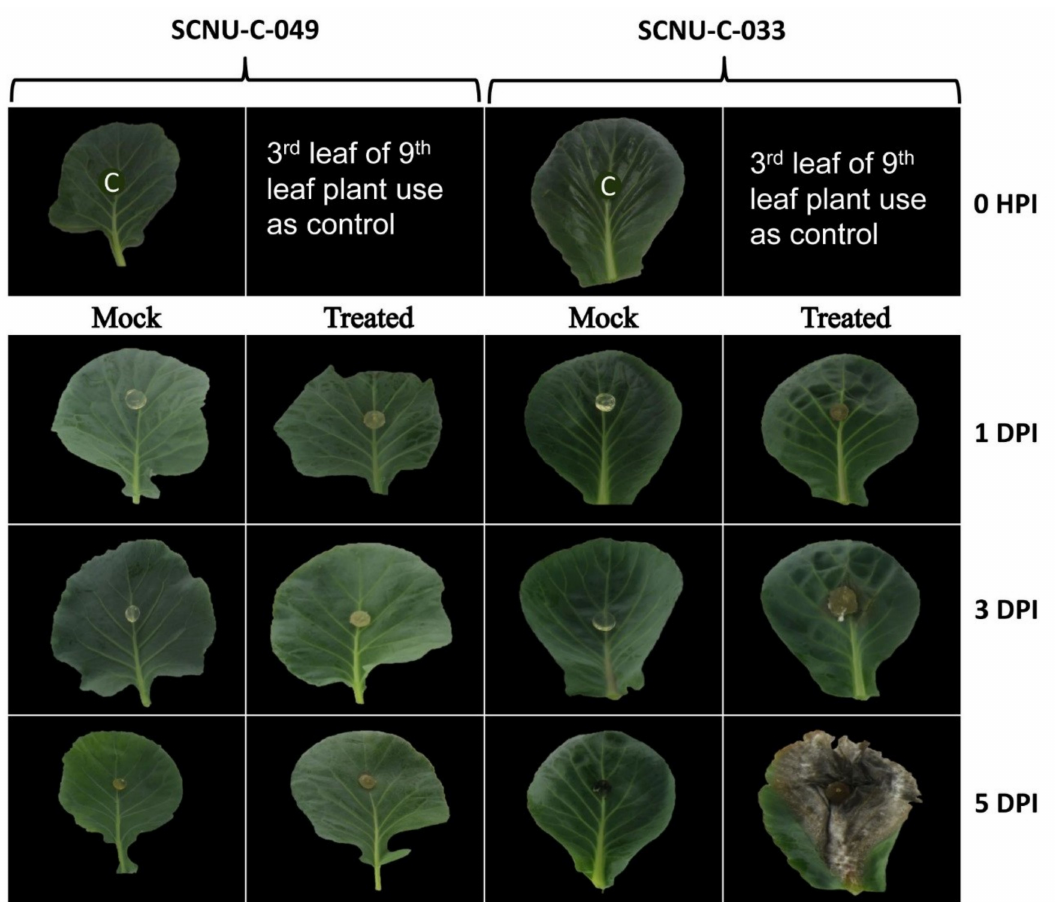
Figure 7. White mold disease progress in resistant (R; SCNU-C-049) and sensitive (S; SCNU-C-033) lines of cabbage. The third-youngest leaf was infected at the of ninth leaf stage of each plant. Infected leaves were examined at 0 hours post inoculation (HPI), and then from 1 to 5 days post inoculation (DPI). C, control plant leaf (no inoculation). ‘Mock’ treatment(s) - were those done with mycelium-free agar